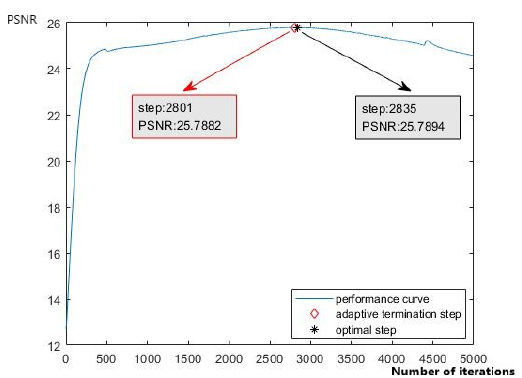
Figure 6. Performance comparison between the adaptive termination step and optimal